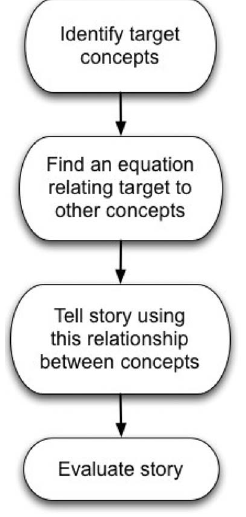
FIG. 2. Schematic diagram of some moves in the epistemic game Mapping Mathematics to